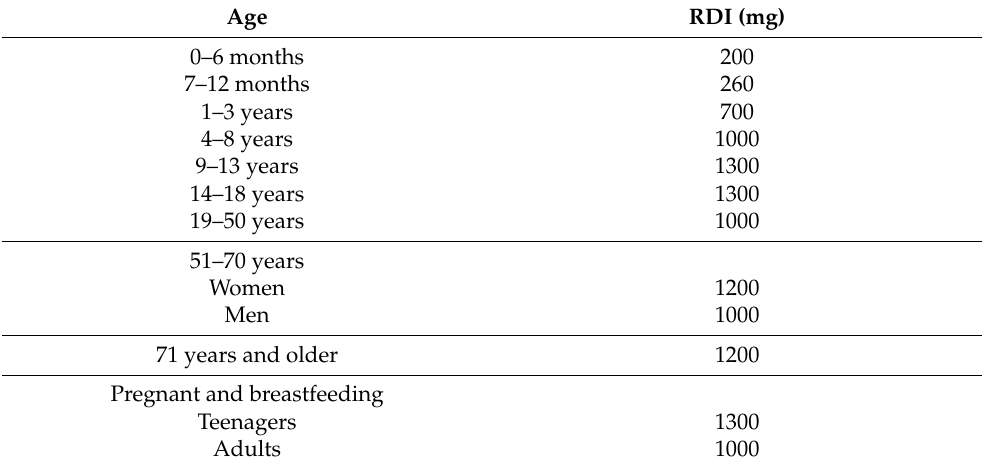
Table 2. Recommended Daily Intake of calcium for various age groups